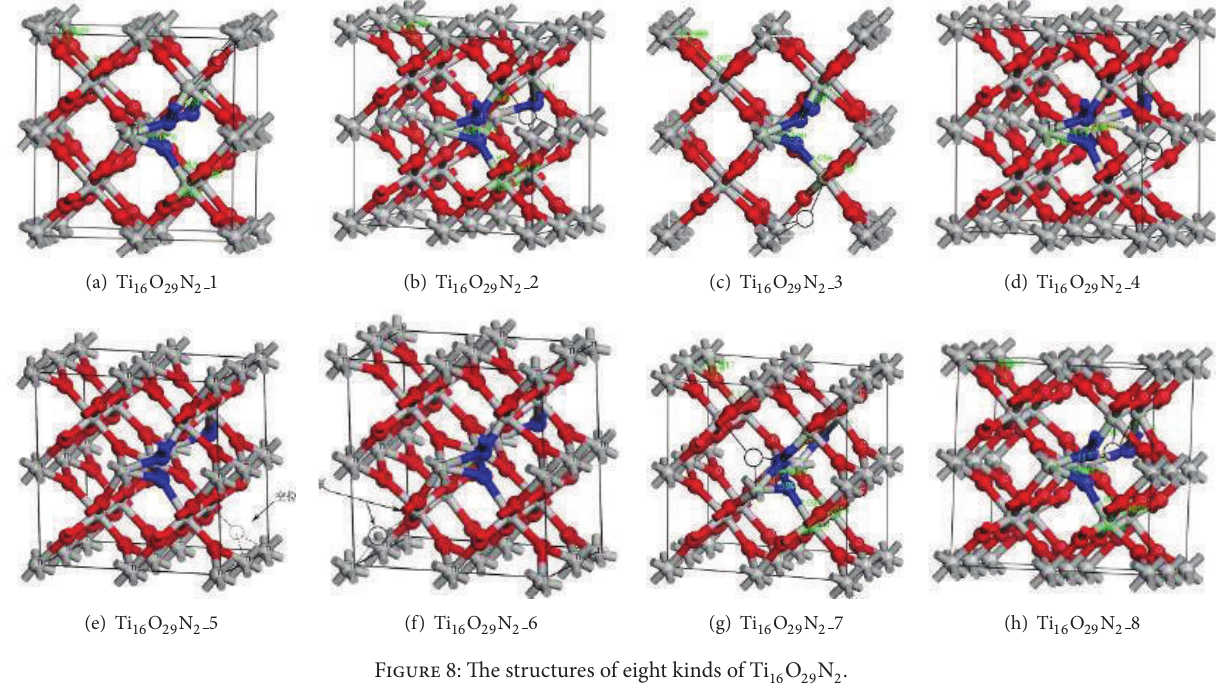
Figure 8: The structures of eight kinds of Ti 16 O 29 N 2 .